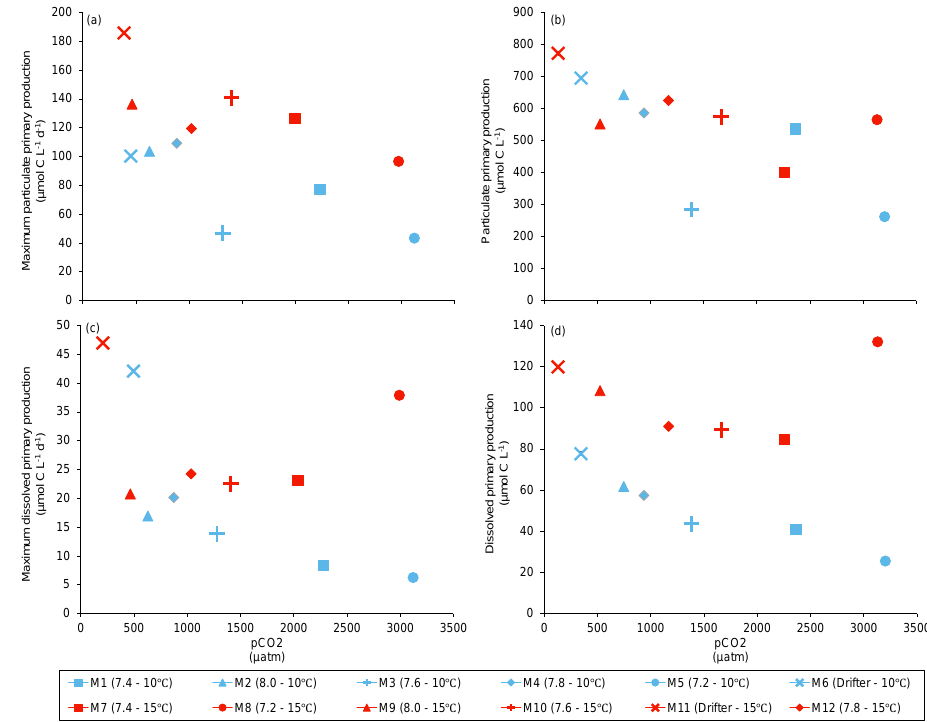
Figure 8. (a) Maximum particulate primary production, (b) time-integrated particulate primary production, (c) maximum dissolved primary production, and (d) time-integrated dissolved primary production over the full course of the experiment (day 0 to day 13). For symbol attribution to treatments, see